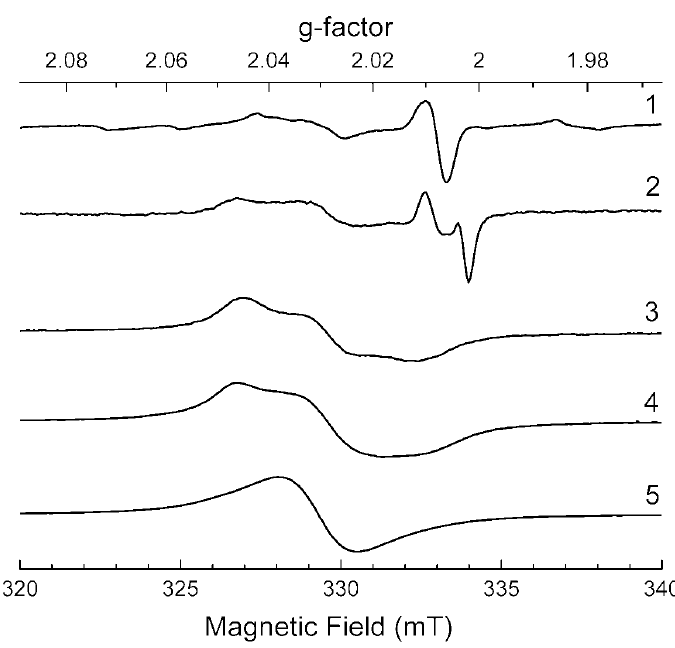
Figure 14. Room-temperature ESR spectra of: 1—LSh; 2—MD; 3—PH; 4—KL; 5—ZK.